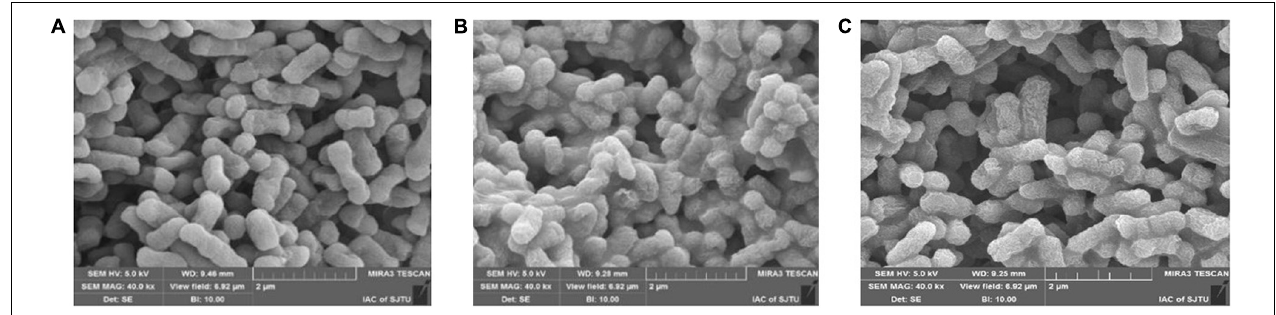
FIGURE 5 | Scanning Electron Microscopy (SEM) micrographs of Salmonella under 0 × MIC (A) , 0.25 × MIC (B) , and 0.5 × MIC (C) of CGA.